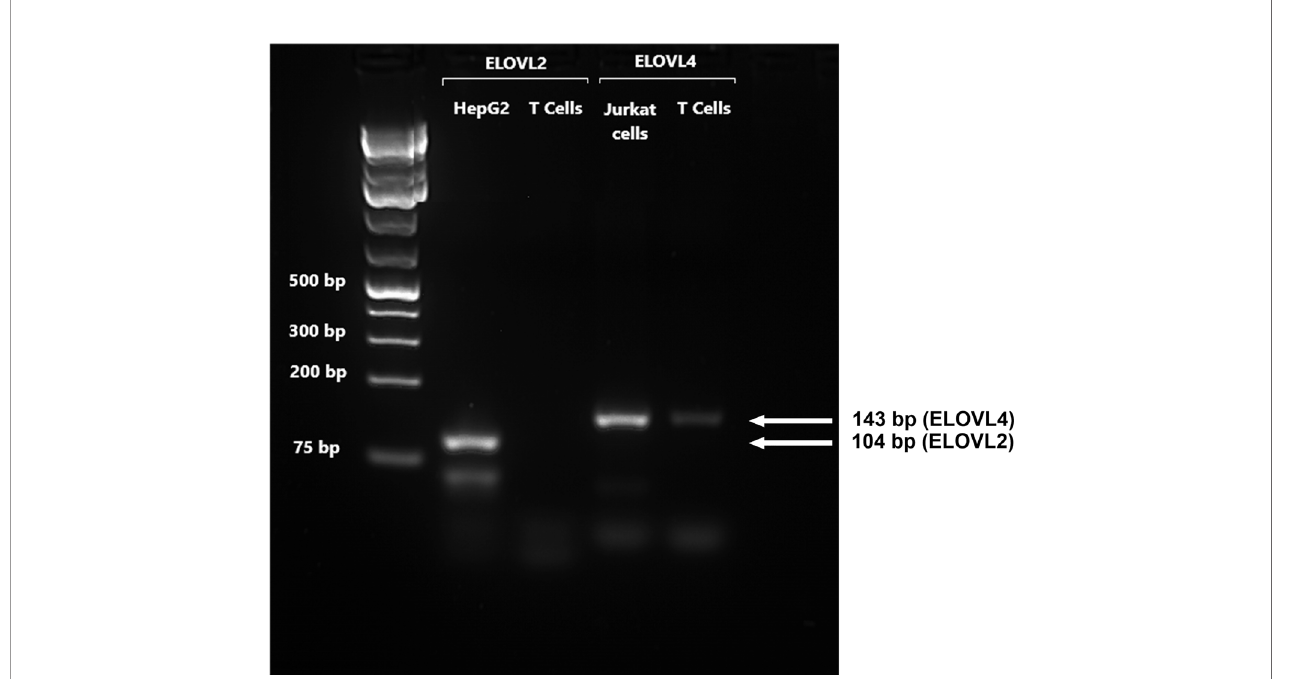
FIGURE 2 | A representative RTPCR analysis of the mRNA expression of ELOVL2 and ELOVL4 in stimulated T cells after 48-h incubation. Bands correspond to PCR products after 40 cycles using T-cell, HepG2, and Jurkat-cell cDNA as templates. HepG2 cells were used as reference for ELOVL2 , as this gene is poorly expressed in Jurkat cells. Jurkat cells were used as the reference for ELOVL4 , which is poorly expressed in liver